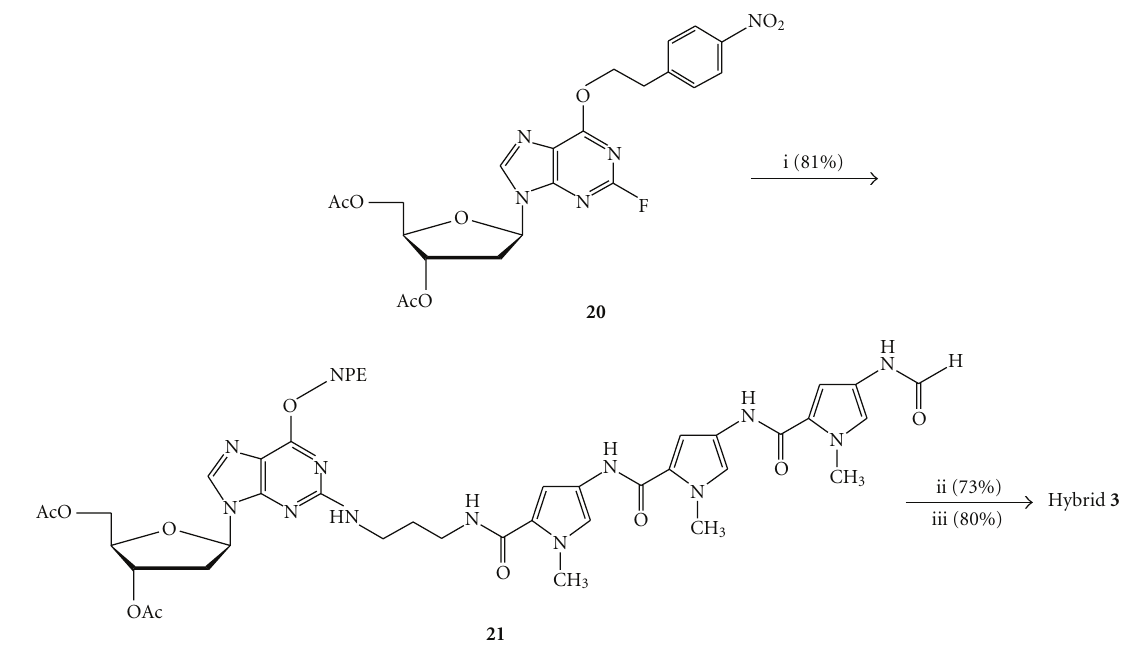
A5 to G5 and T7 to C7, and DNA 3 [d-(5 (cid:2)